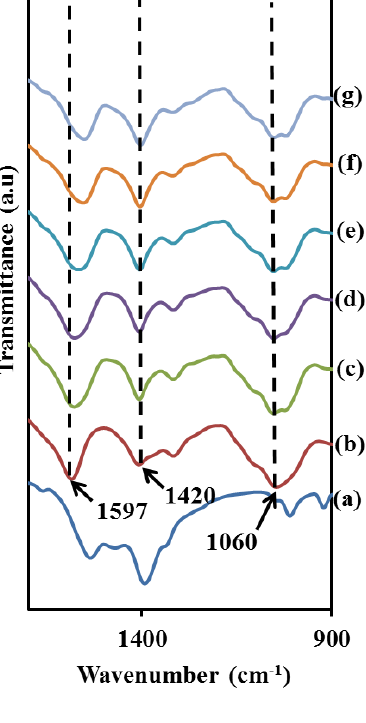
Figure 7. IR spectra of: ( a ) CH ( d ) CMC–CH 40 wt% in the region between 4000 and 550 cm −1